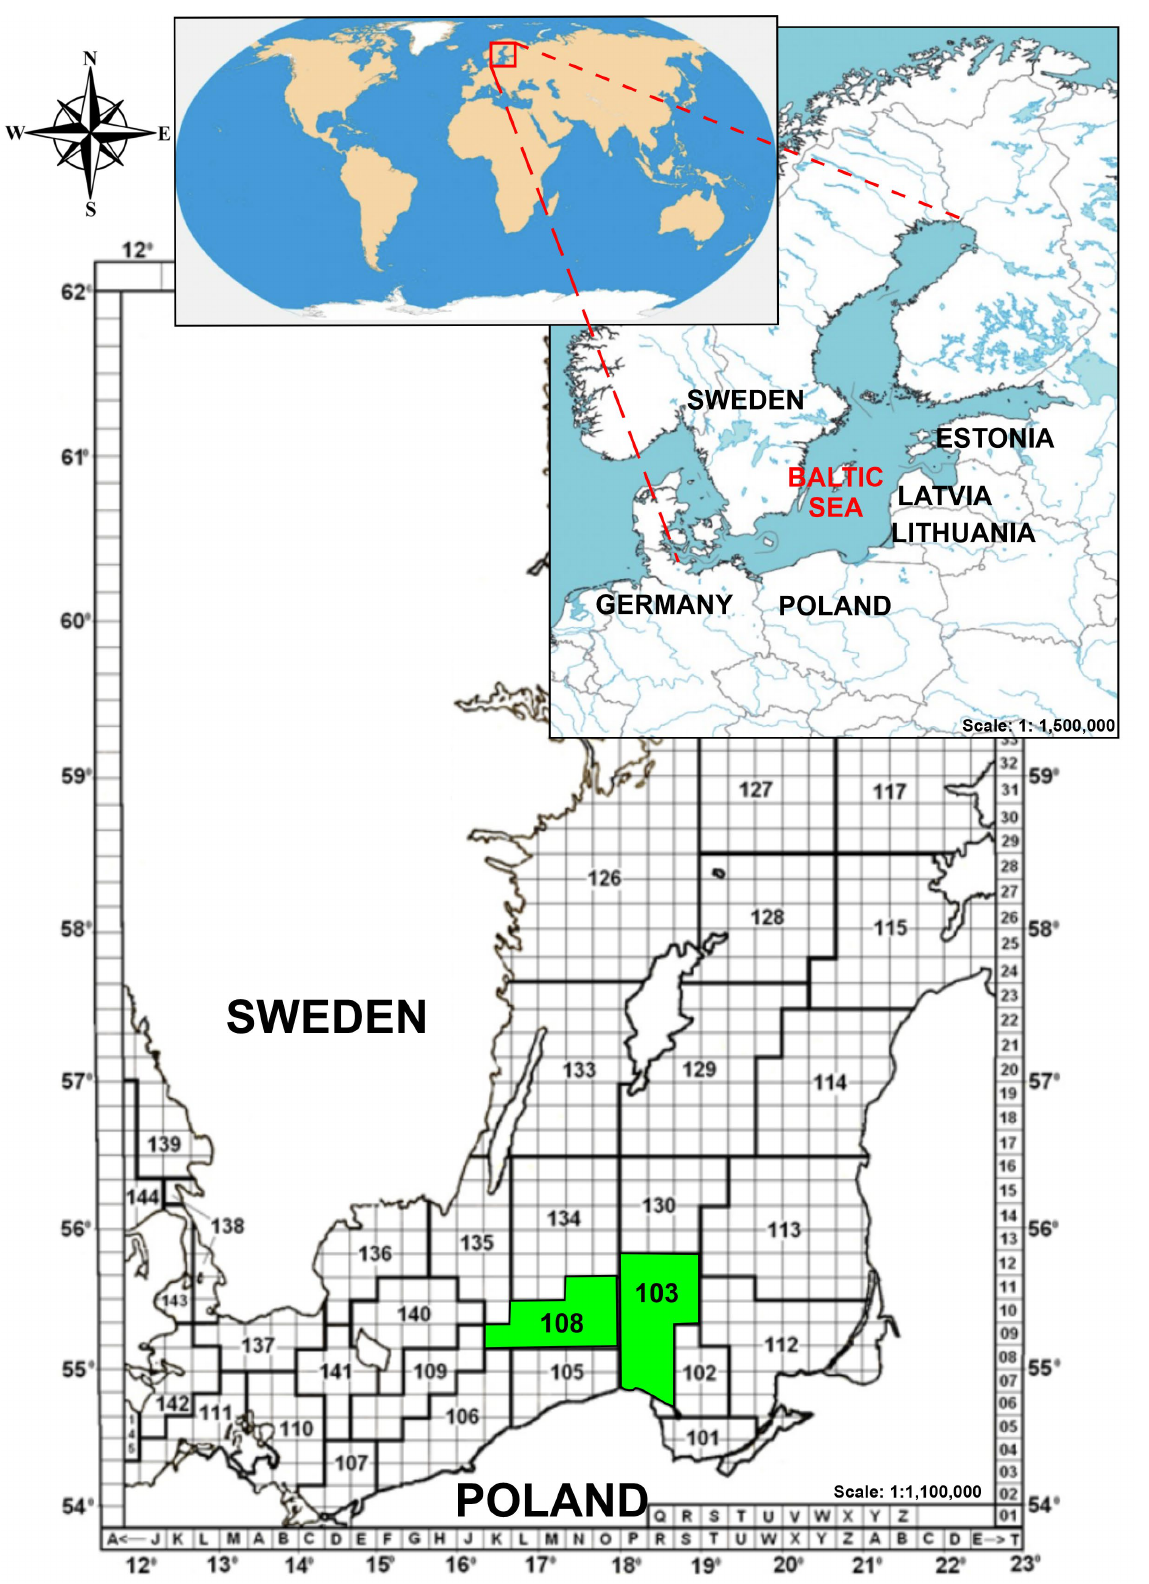
Figure 1. The sampling sites of fish collection in the south Baltic Sea.